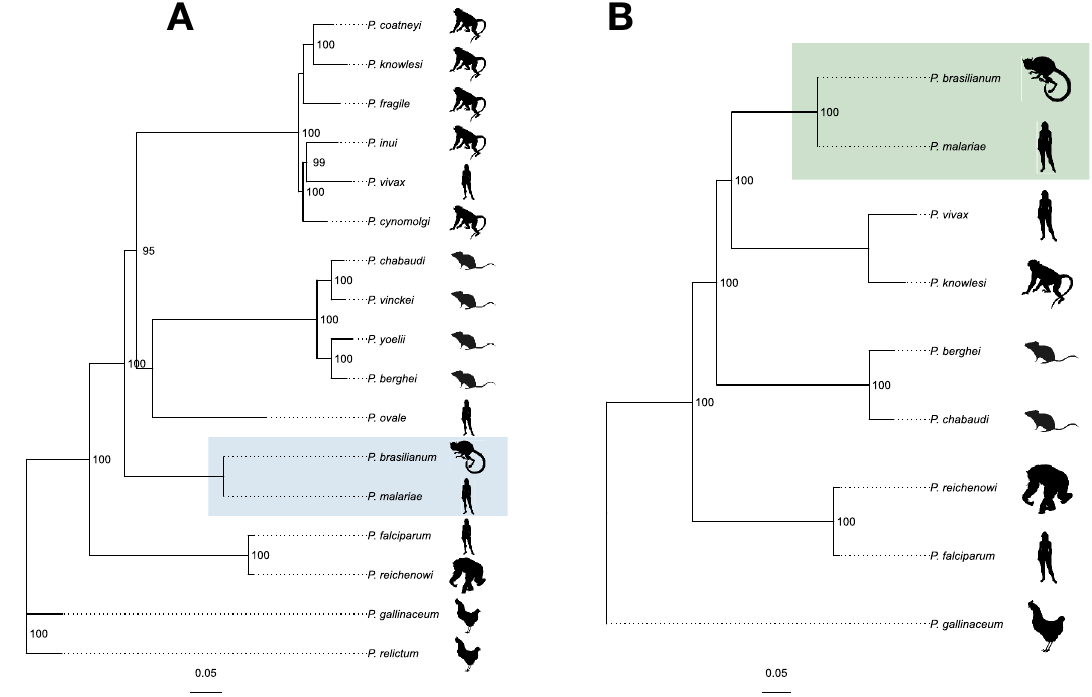
Figure 3. Phylogenetic distances among Plasmodium species visualized by orthologous genes. Multiple sequence alignment was performed across Plasmodium species and an evolutionary tree was generated using the PROTGRAMMAAUTO model of RaxML. ( A ) Phylogenetic tree from a sequence alignment using 82 orthologous groups (1,567 genes) found in all 19 Plasmodium species with an available draft/complete genome. ( B ) Phylogenetic tree from a sequence alignment using 90 orthologous groups (815 genes) found in nine representative Plasmodium species 7 . To the right of each phylogenetic tree is a visual depiction of the primary vector each Plasmodium species infects during the parasite’s asexual life cycle. Colored boxes (blue in A and green in B) depict the locations of Plasmodium brasilianum and Plasmodium malariae